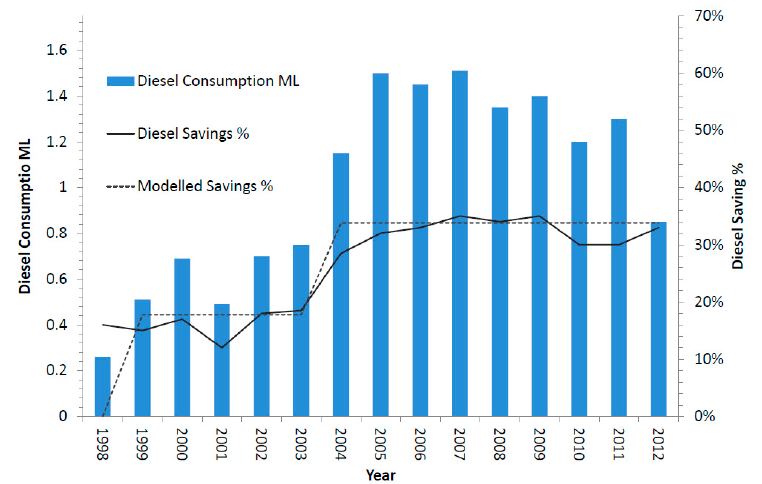
Figure 2. Annual diesel consumption (megaliters) and the associated fuel savings under increasing RE integration, observed and modeled for King Island power system, 1998–2012, [34]. Diesel savings represents the annual fuel savings returned within a year, in comparison to a 100% diesel-reliant system.